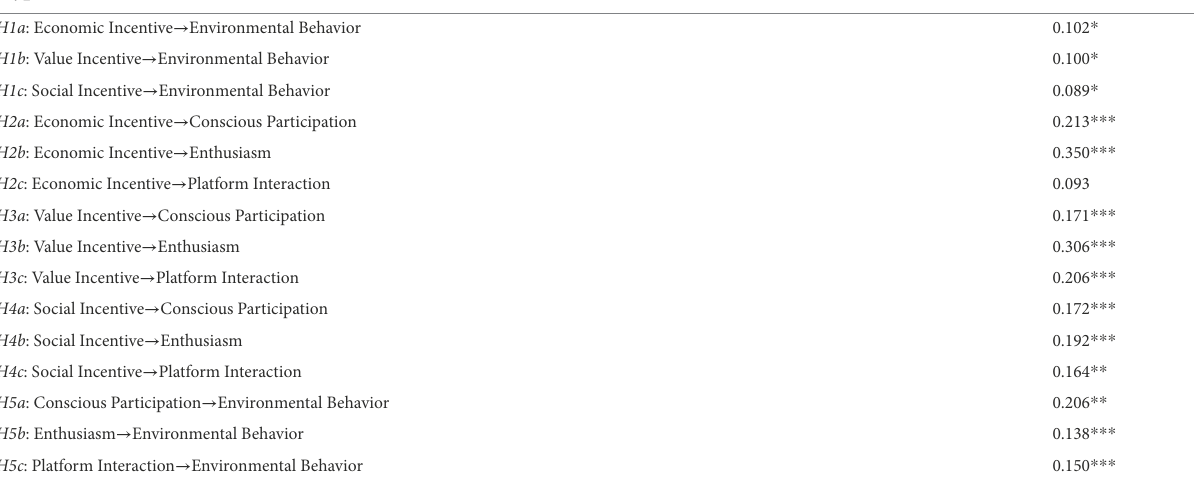
TABLE 4 Estimation results of structural equation model.